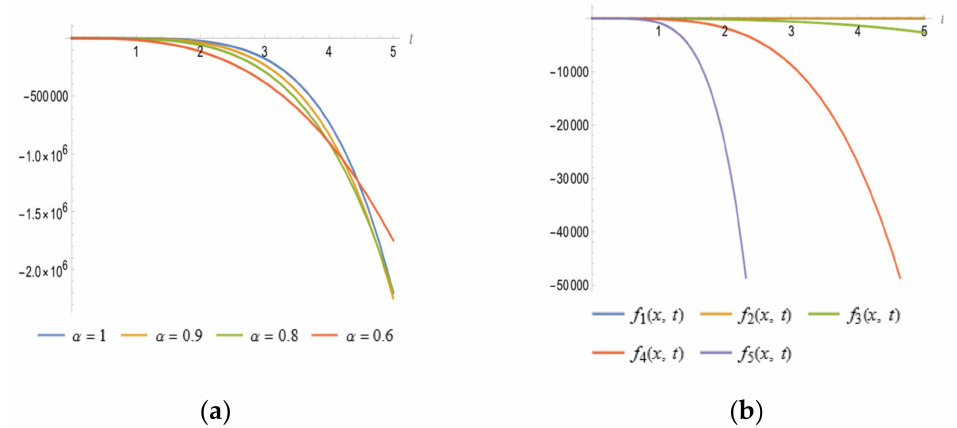
Figure 7. ( a ) The 2D graphic of f 5 ( x , t ) at p = 1.2 and x = 0.8 for different values of α in Example 3. ( b ) The 2D graphic of f n ( x , t ) , n = 1,2,3,4,5, at p = 1.2, α = 1, and x = 0.8 in Example 3. In addition, one can see that with increasing time, the concentricity of the cancer cells decreases and eventually reaches